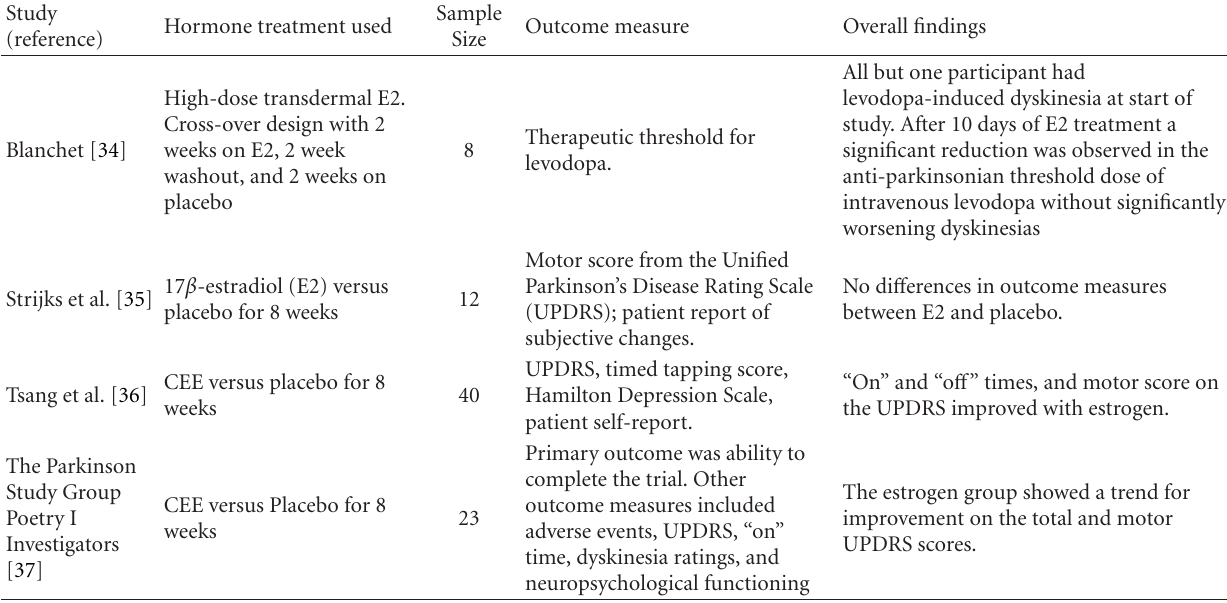
Table 4: RCTs of ERT and Parkinson’s